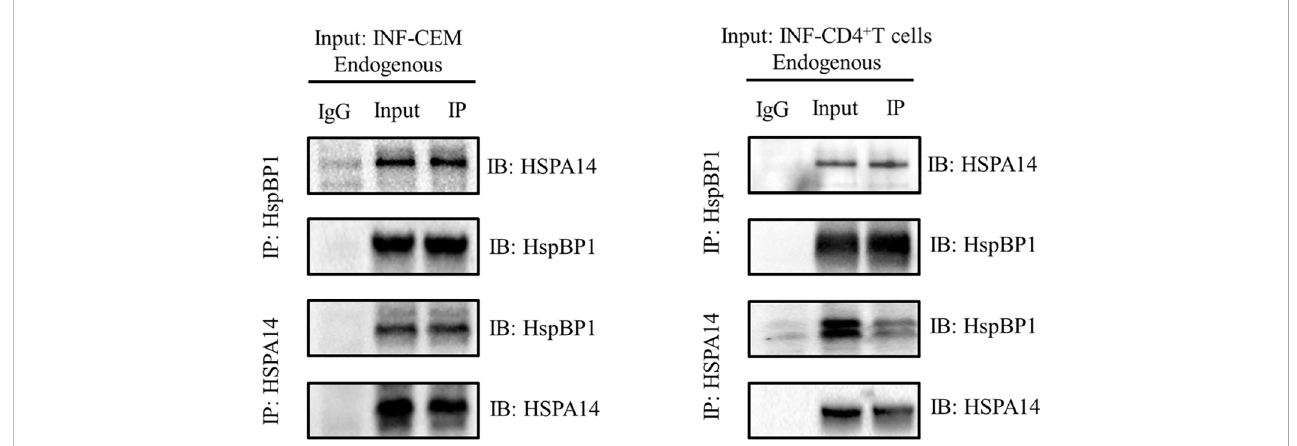
FIGURE 1 Co-IP to detect the interaction between HspBP1 and HSPA14. Co-immunoprecipitation showing interaction of HspBP1 with HSPA14 at endogenous level in infected CEM cells and CD4+T cells of acute HIV infected patients.